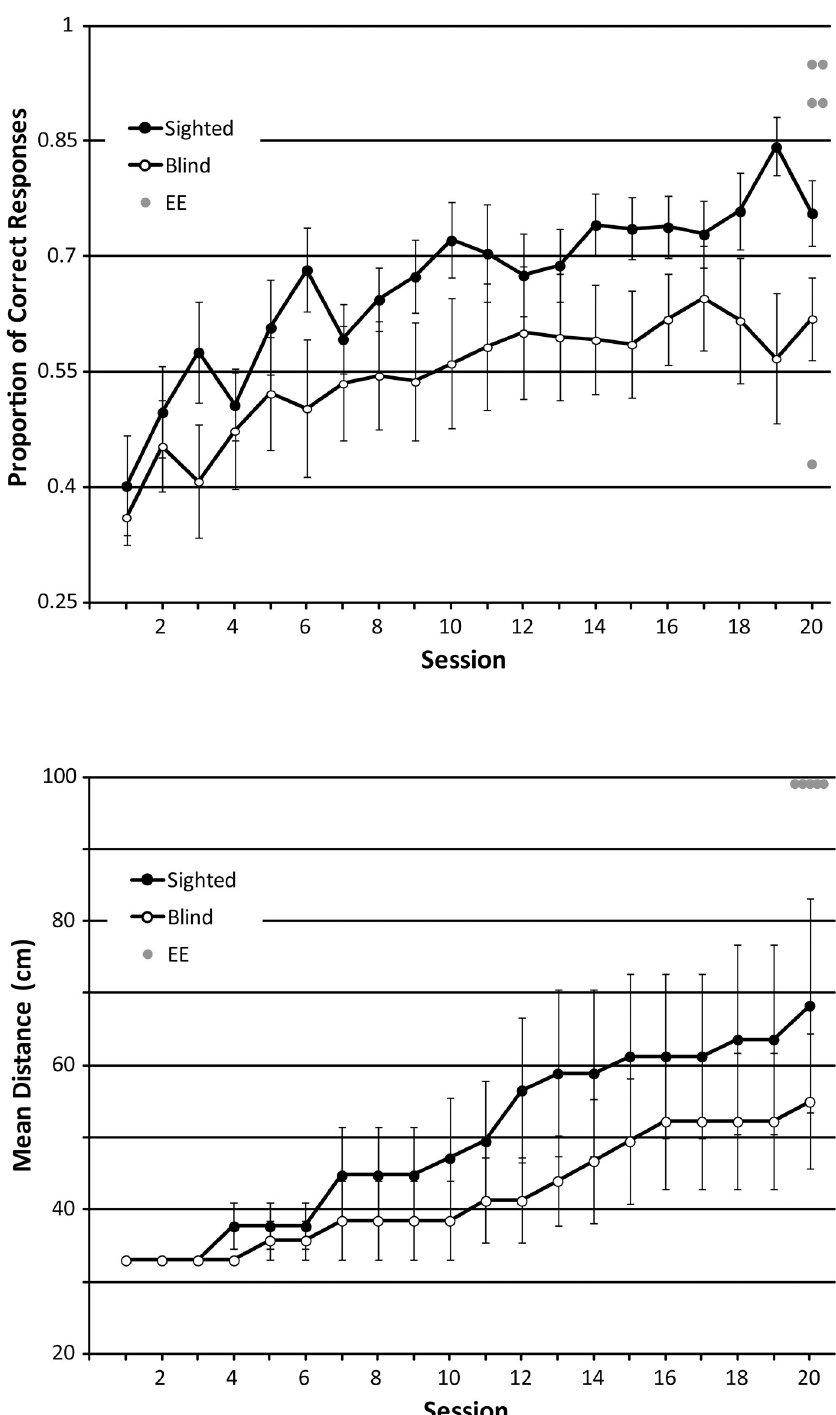
Fig 7. Performance in the orientation training task. Top panel: Proportion of correct answers across sessions. Chance level for proportion correct is.25. Bottom panel: Distance at which participants performed the task across sessions. Data from SCs and BCs are shown as black and white circles, respectively with each symbol representing the average and error bars representing the standard error of the mean across participants. Data from experts (n = 5) who completed only a single session without training and positioned at 100 cm distance are shown as grey circles. For comparison, they have been plotted at session 20.